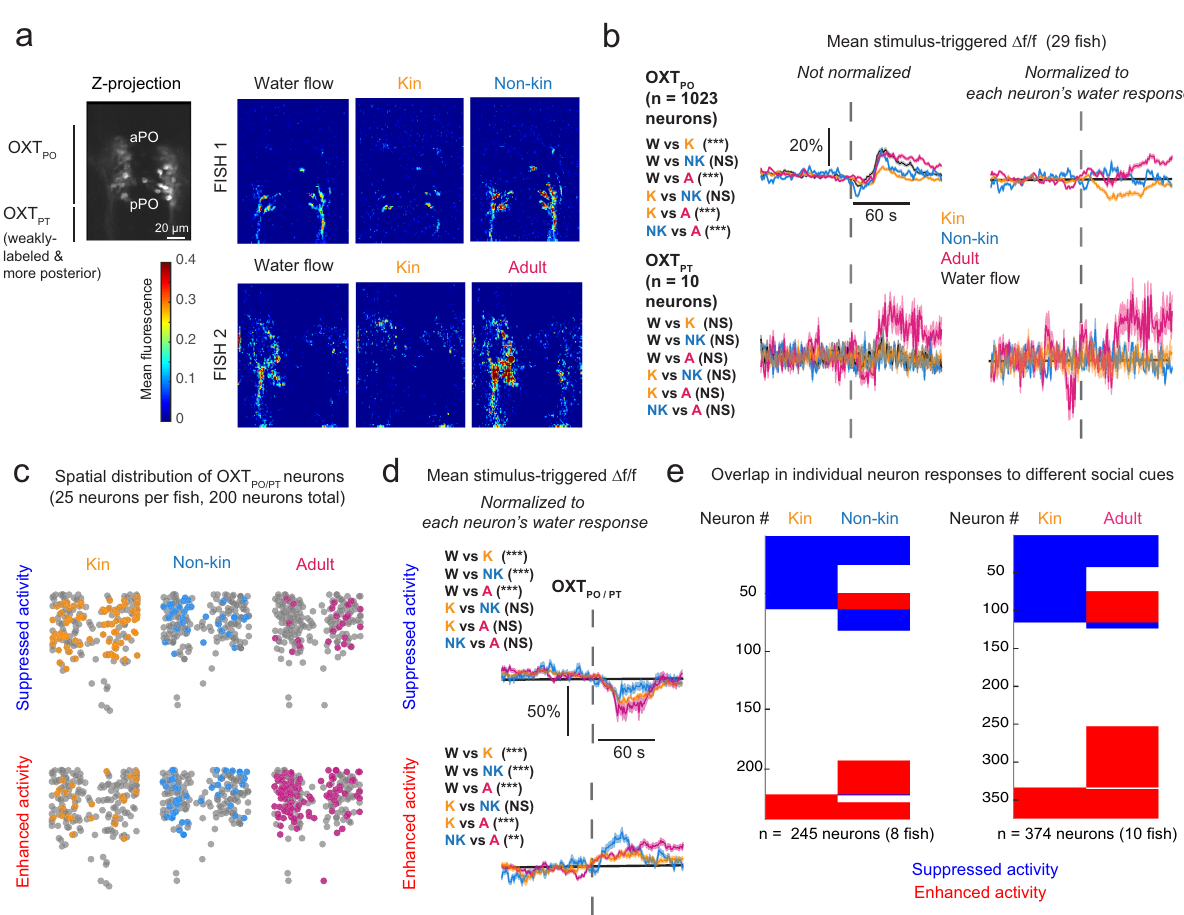
Fig. 2 Calcium imaging con fi rms OXT neuron modulation by conspeci fi c cues. a Left: Maximum z-projection of oxytocin neurons. The Tg(oxt:Gal4; UAS:GCaMP6s) transgenic line labels OXT PO neurons strongly, with weaker labeling of the more ventro-posteriorly located OXT PT cluster. Scale bar = 20 µ m. Right: Mean OXT neuron fl uorescence over a 60-s period post stimulus from two different fi sh, one imaged with kin and non-kin water (top), and another with kin and adult water (bottom). This experiment was repeated on 8 and 10 fi sh, respectively, with similar results. b Left: Mean stimulus-triggered calcium activity ( Δ f/f) of OXT PO (top) and OXT PT (bottom) neurons. All fi sh (29 fi sh, n = 1033 neurons) were imaged with water or kin water, some also with either non-kin (8 fi sh, n = 245 neurons) or adult water (10 fi sh, n = 374 neurons). Of all neurons imaged, only 10 were from the OXT PT population. Right: Mean stimulus- triggered Δ f/f of each neuron normalized to its own mean water- fl ow response. Gray broken line indicates stimulus onset. Shading indicates SEM. Asterisks show statistical comparison of mean Δ f/f over a 60-s post-stimulus period for different cues, two-sided Kruskal – Wallis Test with Tukey – Kramer correction. OXT PO : *** p = 1.4×10 − 9 (water vs kin)/ p = 0.13 (water vs non-kin)/*** p = 4.0×10 − 11 (water vs adult)/ p = 0.30 (kin vs non-kin)/*** p = 0 (kin vs adult)/ *** p = 2.5×10 − 11 (non-kin vs adult). OXT PT : p = 0.99 (water vs kin)/ p = 0.76 (water vs non-kin)/ p = 0.97 (water vs adult)/ p = 0.85 (kin vs non-kin)/ p = 1 (kin vs adult)/ p = 0.95 (non-kin vs adult). c Spatial distribution and percentages of neurons that show either suppressed (top) or enhanced (bottom) responses to each cue relative to water. See Methods and Supplementary Fig. 2c for details. d Mean stimulus-triggered Δ f/f of neurons classi fi ed as being suppressed (top) or enhanced (bottom) by each cue, normalized to their mean water- fl ow response. Shading indicates SEM. Asterisks show statistical comparison of mean Δ f/f over a 60-s post-stimulus period for different cues, two-sided Kruskal – Wallis test with Tukey – Kramer correction. For water responses, only neurons that had suppressed or enhanced activity induced by any of the other cues were included in the statistical analysis. Suppressed activity: *** p = 0 (water vs kin)/ *** p = 1.3×10 − 7 (water vs non-kin)/*** p = 8.2×10 − 7 (water vs adult)/ p = 1 (kin vs non-kin)/ p = 0.71 (kin vs adult)/ p = 0.84 (non-kin vs adult); n = 429 (water)/390 (kin)/47 (non-kin)/65 (adult). Enhanced activity: *** p = 6.7×10 − 14 (water vs kin)/*** p = 2.8×10 − 10 (water vs non-kin)/*** p = 0 (water vs adult)/ p = 0.88 (kin vs non-kin)/*** p = 8.5×10 − 7 (kin vs adult)/** p = 0.0043 (non-kin vs adult); n = 265 (water)/117 (kin)/55 (non-kin)/116 (adult). e Left: overlap between kin and non-kin water responses. Right: overlap between kin and adult water responses. Red = enhancement, Blue = suppression, White = no change. Kin cues induced the highest percentage of suppression (25 – 30%) and lowest percentage of activation (9 – 11%), whereas adult cues induced the lowest percentage of OXT neuron suppression (14%) and highest percentage of activation (46%) of OXT neurons. Non-kin cues induced an intermediate level of OXT neuron suppression (18%) and activation (23%). See Supplementary Fig. 2d, e for additional visualization. Source data are provided as a Source Data fi le.